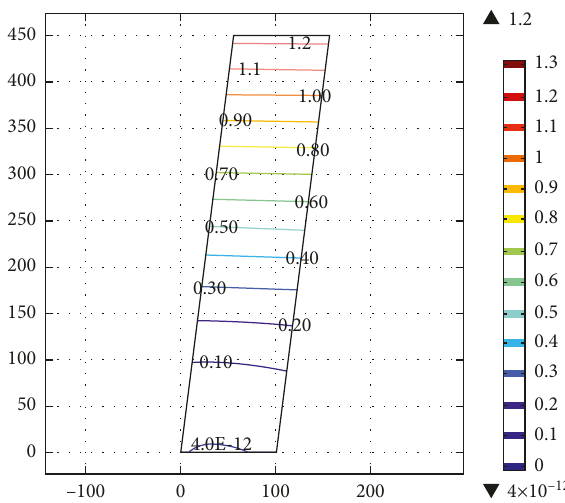
Figure 12: Horizontal displacement of the rock column at a mining depth of 450